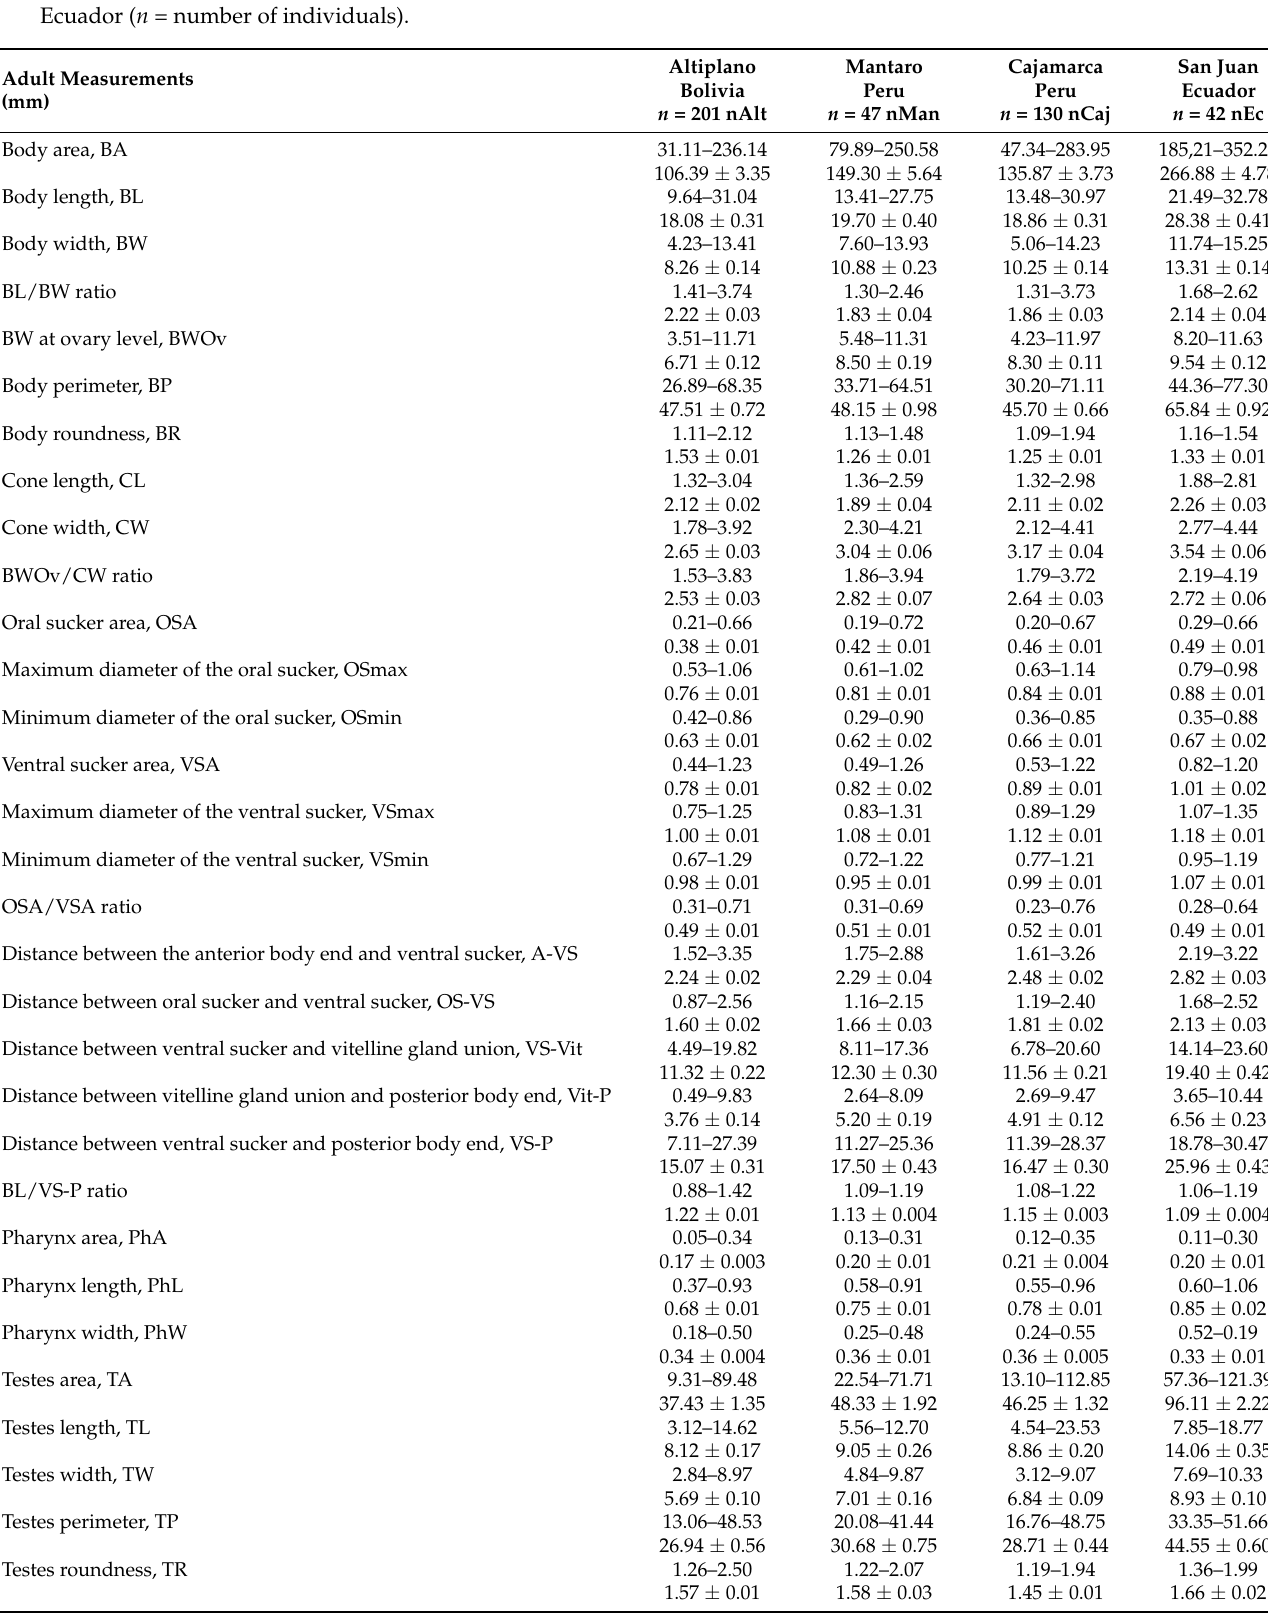
Table 1. Comparative morphometric data (extreme values, mean and standard deviation) of natural liver flukes collected in highland sheep from the Northern Altiplano in Bolivia, Mantaro valley and Cajamarca valley in Peru, and San Juan in Ecuador ( n = number of